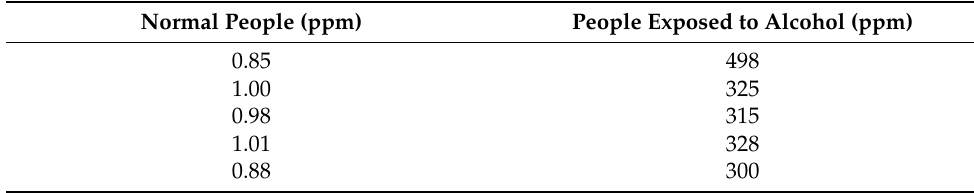
Table 6. Blood alcohol levels for the experimental group and normal people.